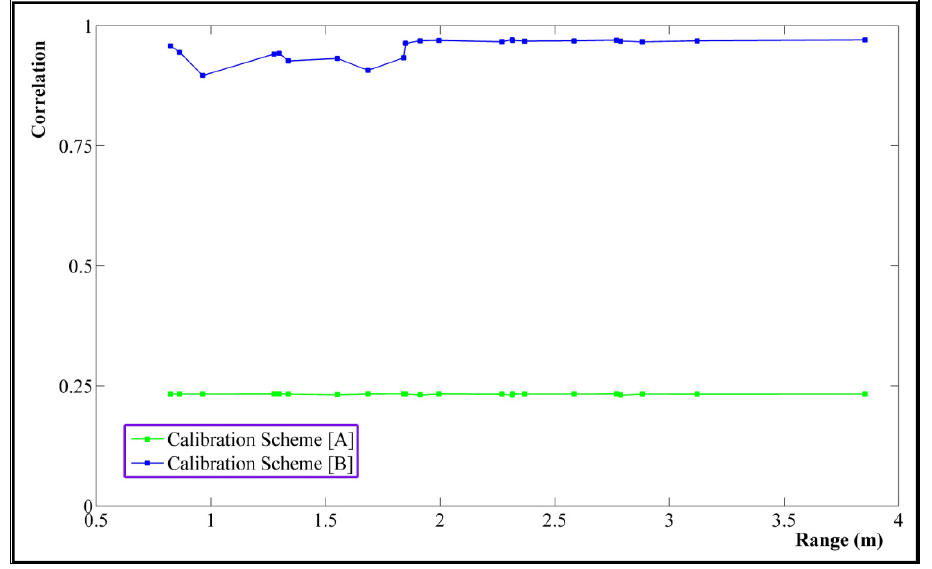
Figure 8. Correlations between principal distance and perspective centre of PMD camera vs.